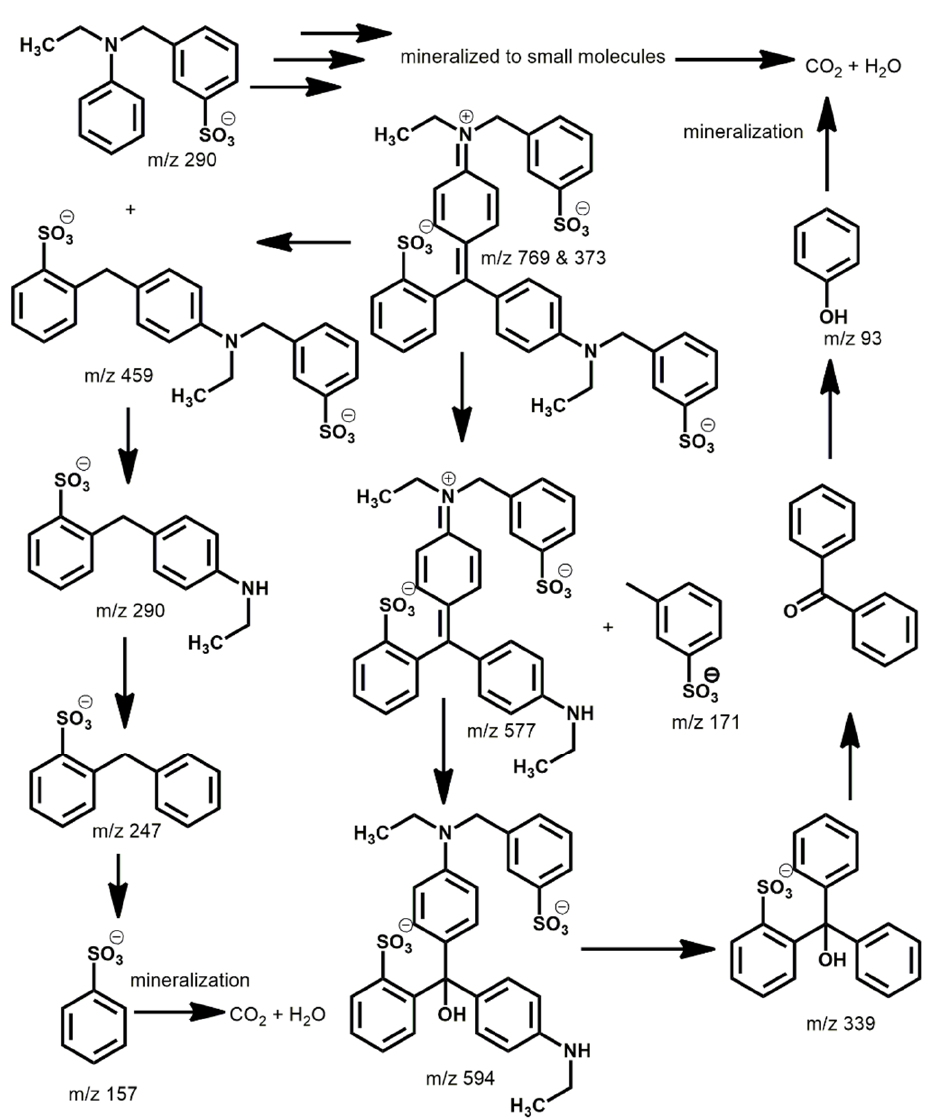
Figure 10. Possible intermediates for the degradation of the EG dye in the presence of the photo- catalyst SnP@MCM − 41 . lyst SnP@MCM − 41